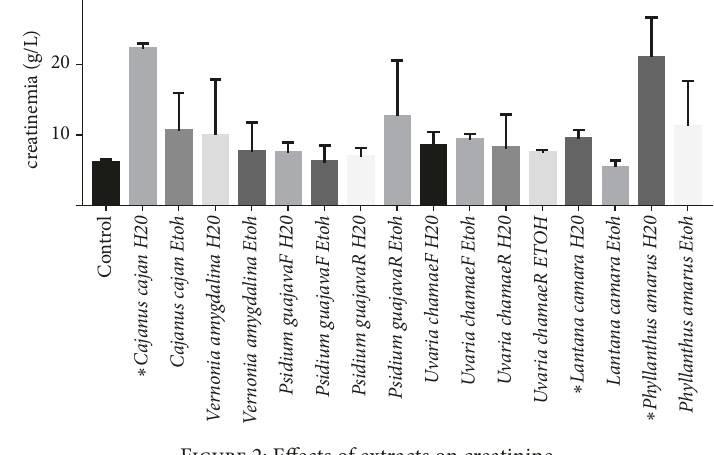
Figure 1: Effects of extracts on uremia.